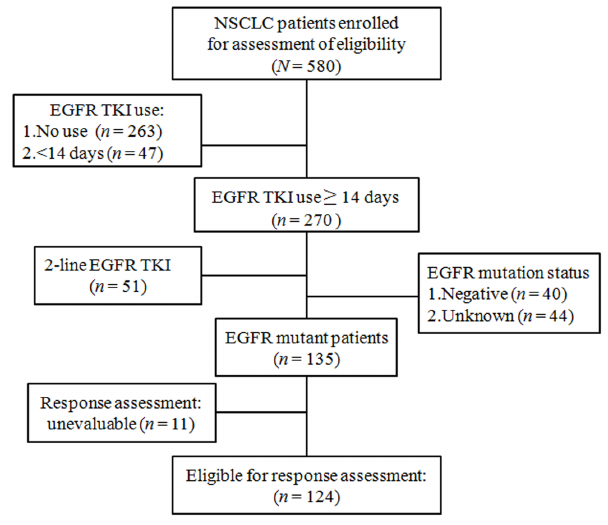
Figure 1. Flow chart of patients enrolled for analysis. NSCLC: non-small cell lung cancer, EGFR : epidermal growth factor receptor, TKI: tyrosine kinase inhibitor